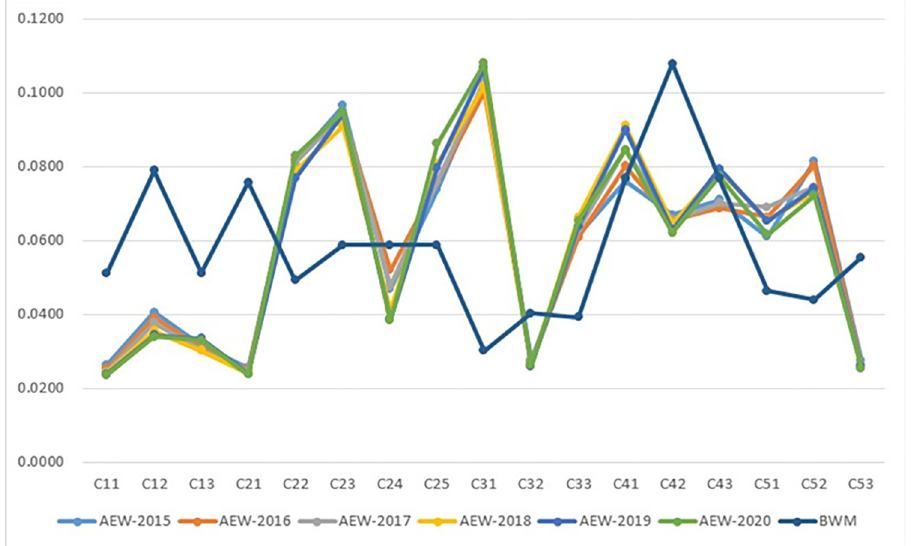
Fig 4. The difference of objective weights obtained via the AEW method from 2015 to 2020 and subjective weights obtained via the BWM.